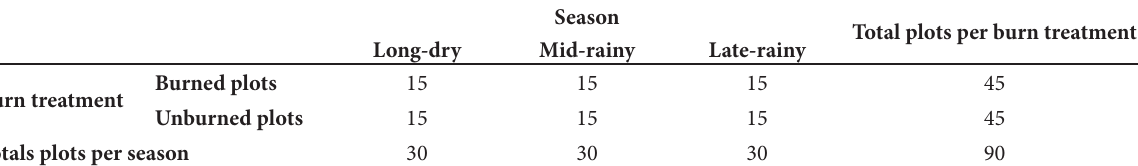
Table 1. Plots by burn treatment and season.